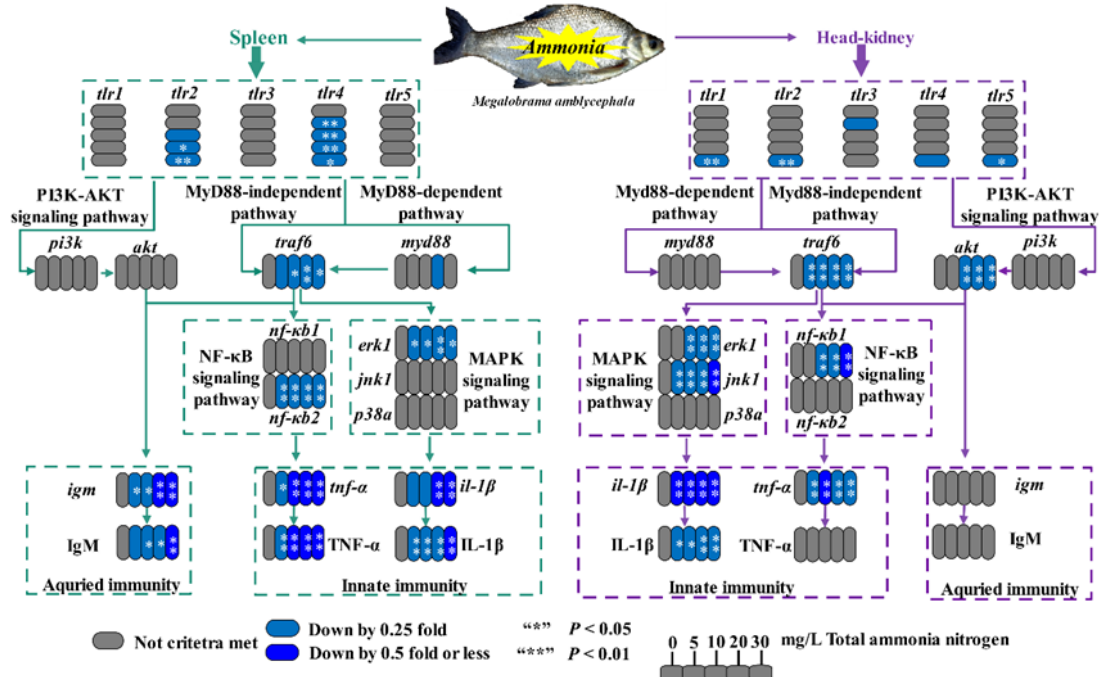
Figure 6. Relative mRNA levels of TLR signaling pathway genes as well as the contents of TNF- α, IL- 1β and IgM in the spleen and head-kidney of M. amblycephala . Values expressed as means ± SE of six duplicates. igm : immunoglobulin M, il- 1β : interleukin 1β, tnf- α : tumor necrosis factor α, jnk1 : c-Jun N- terminal kinase1, erk1 : extracellular regulated protein kinase 1, p38α : mitogen activated protein